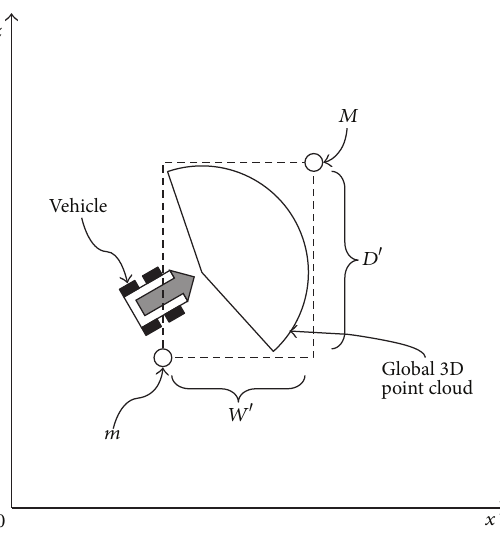
Figure 2: Structure to express a local 3D point cloud in a global coordinate system in a fixed memory (from top view).